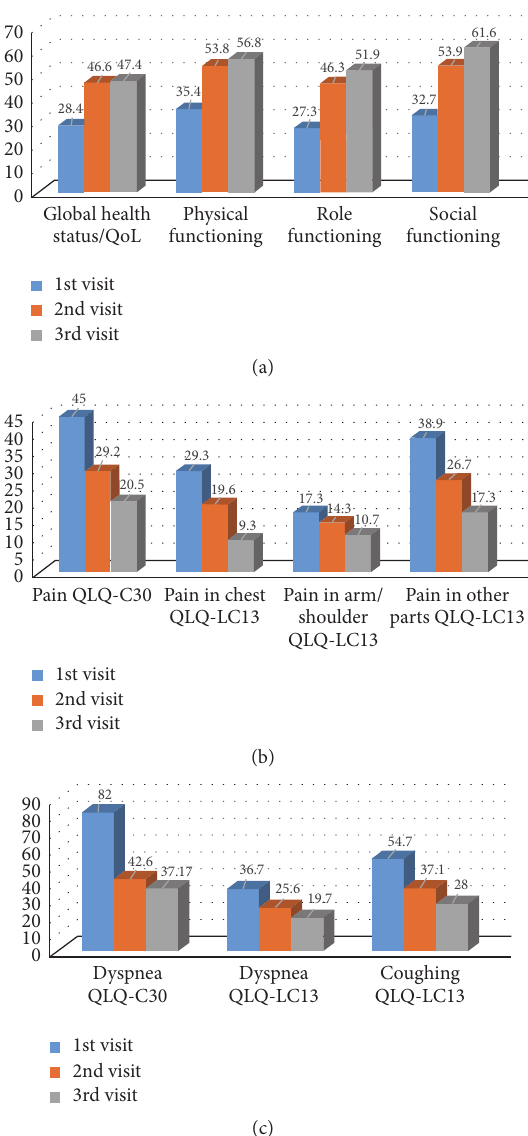
Figure 2: (a) Comparison of global health status/Quality of Life and its functional scales in 1st visit and after ASEPT pleural catheter insertion (2nd and 3rd visits) according to the EORTC QLQ-C30. (b) Comparison of pain scores in 1st visit and after ASEPT pleural catheter insertion (2nd and 3rd visits) according to the EORTC QLQ-C30 and QLQ-LC13. (c) Comparison of dyspnea and coughing scores in 1st visit and after ASEPT pleural catheter insertion (2nd and 3rd visits) according to the EORTC QLQ-C30 and QLQ-LC13. These improvements were sustained during the study period of 6